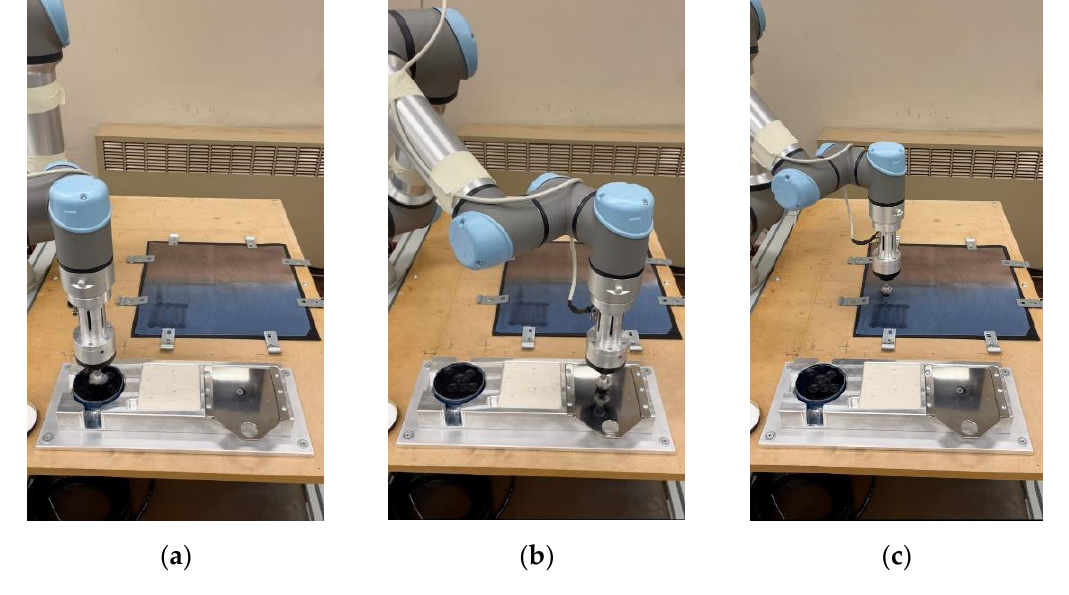
Figure 17. Three phases of the process: ( a ) picking up of the polish; ( b ) homogenization of the polish; ( c ) polishing.